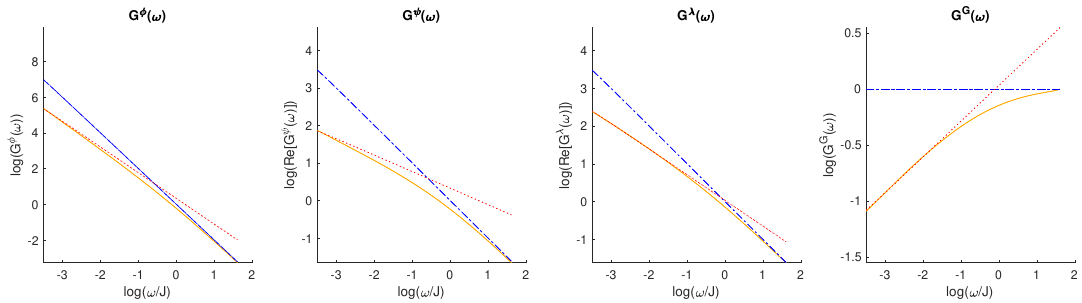
Figure 1. Numerical solutions to the Schwinger-Dyson equations. The blue dash-dot lines are the free propagators in the UV, the red dotted lines are the IR solutions. The yellow curves are result from solving the Schwinger-Dyson equations numerically. One observes that the numerical solutions interpolate between the UV and IR behaviors. The calculation is done for q = 3, (cid:22) = 1 :